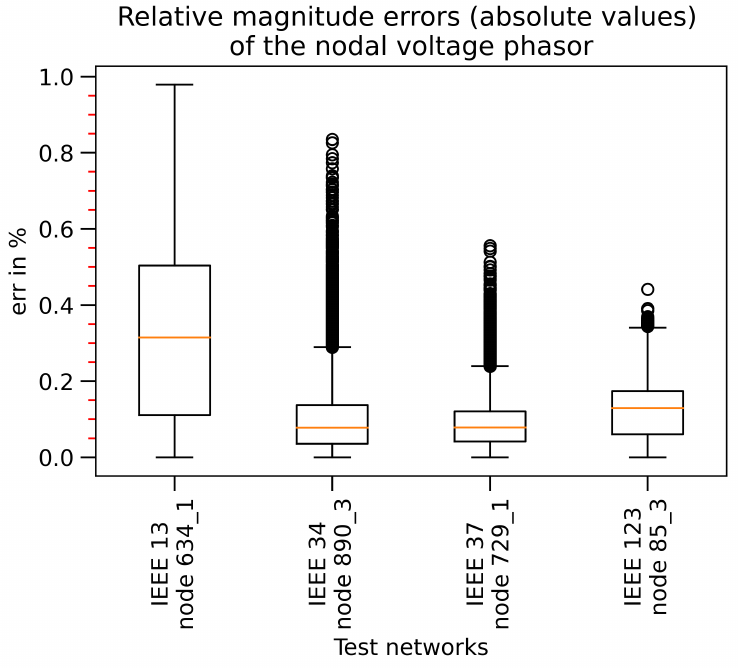
Figure 13. Distribution of absolute errors of nodal voltage phasor magnitudes for nodes with the highest errors (scenario considering the load shape).